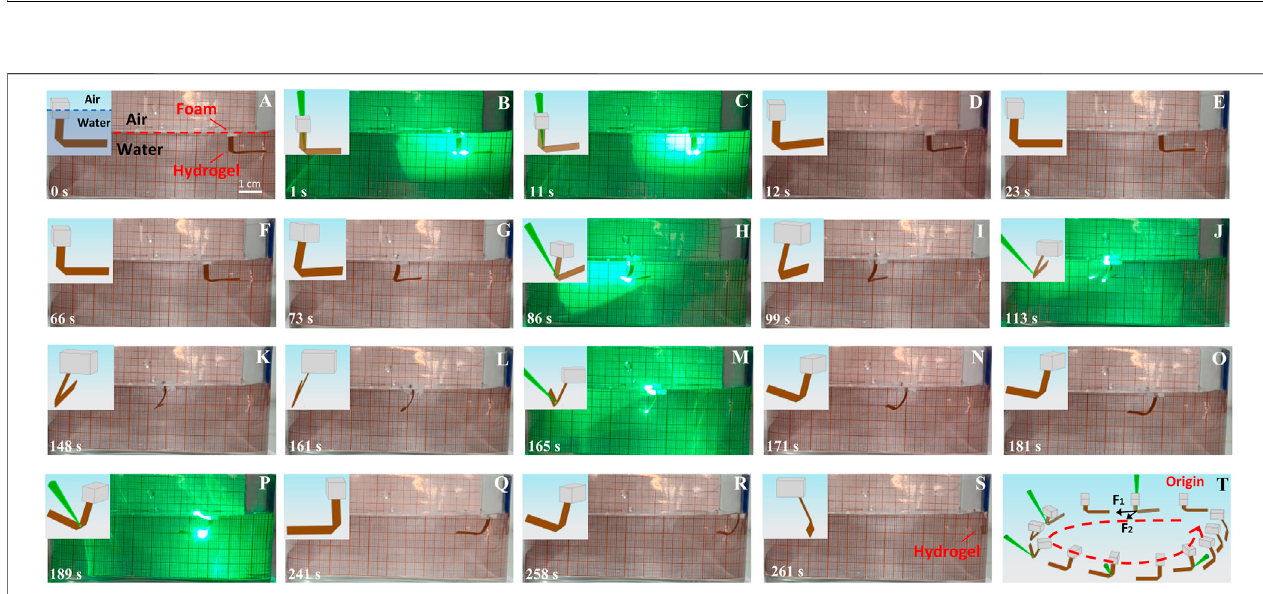
FIGURE 5 | Movement of a fl oat with a boomerang-like hydrogel actuator driven by a 520-nm laser. (A – S) Optical images of the fl oating foam and hydrogel actuator. Inset: three-dimensional (3D) model of the fl oat and hydrogel actuator. (T) Moving path of the fl oat and hydrogel actuator. Scale bar of (A) is 1 cm.